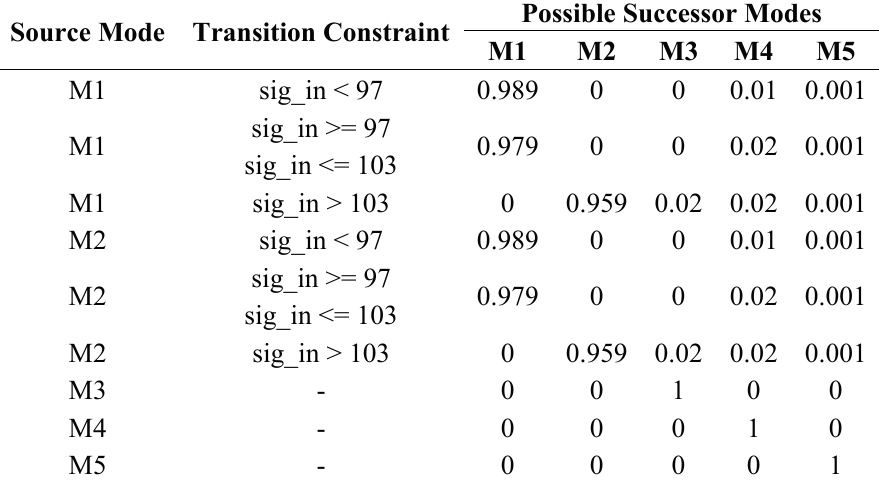
Table 3. The transition matrix for voltage converting